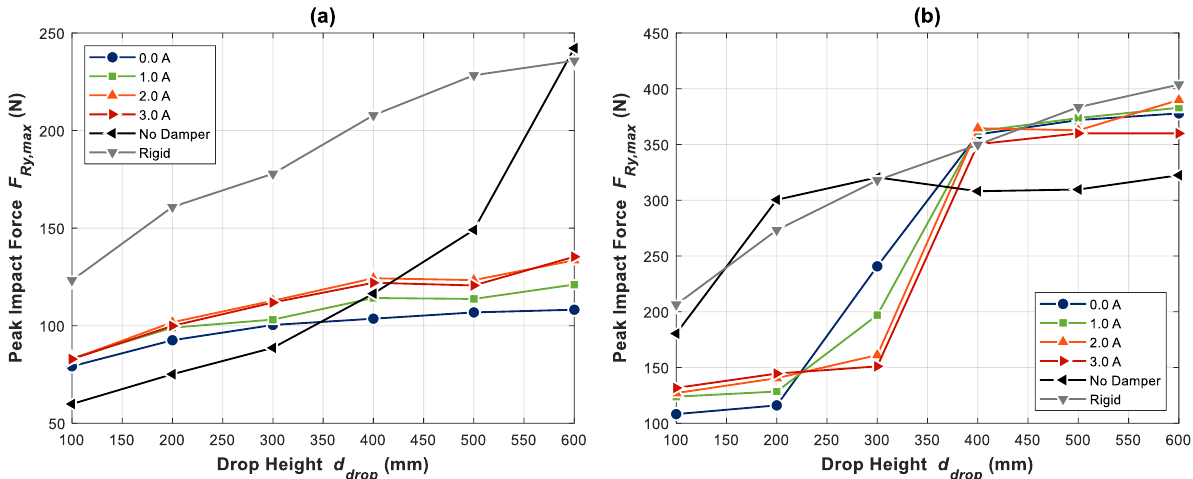
Figure 9. Peak impact force for impact tests with masses of ( a ) 2.65 kg, and ( b ) 4.60 kg.